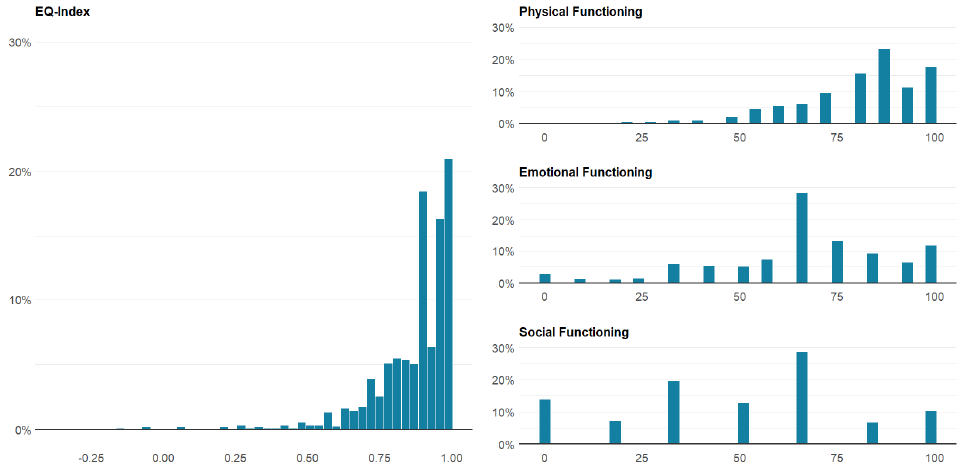
Figure 1. The score distribution of HRQoL measures.